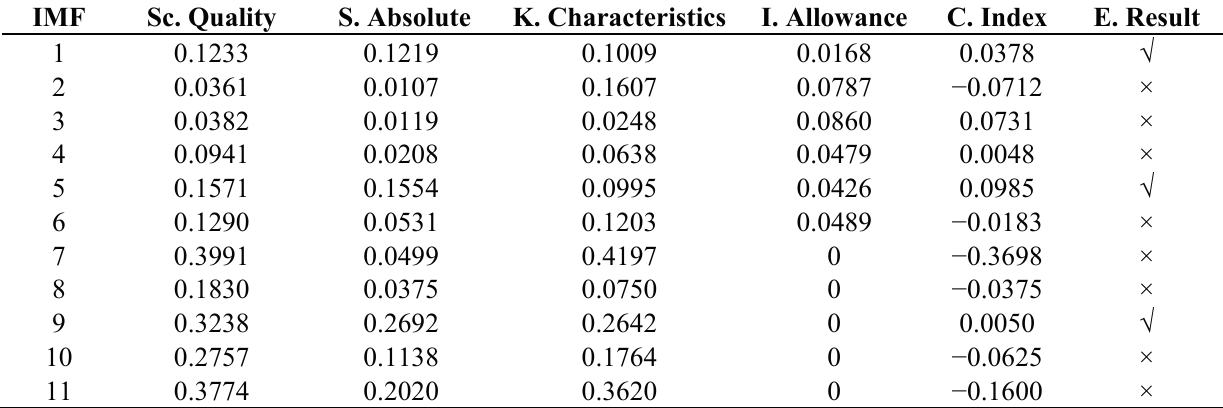
Table 2. IMFs’ confidence index calculation for the undamaged axle bearing vibration. IMF